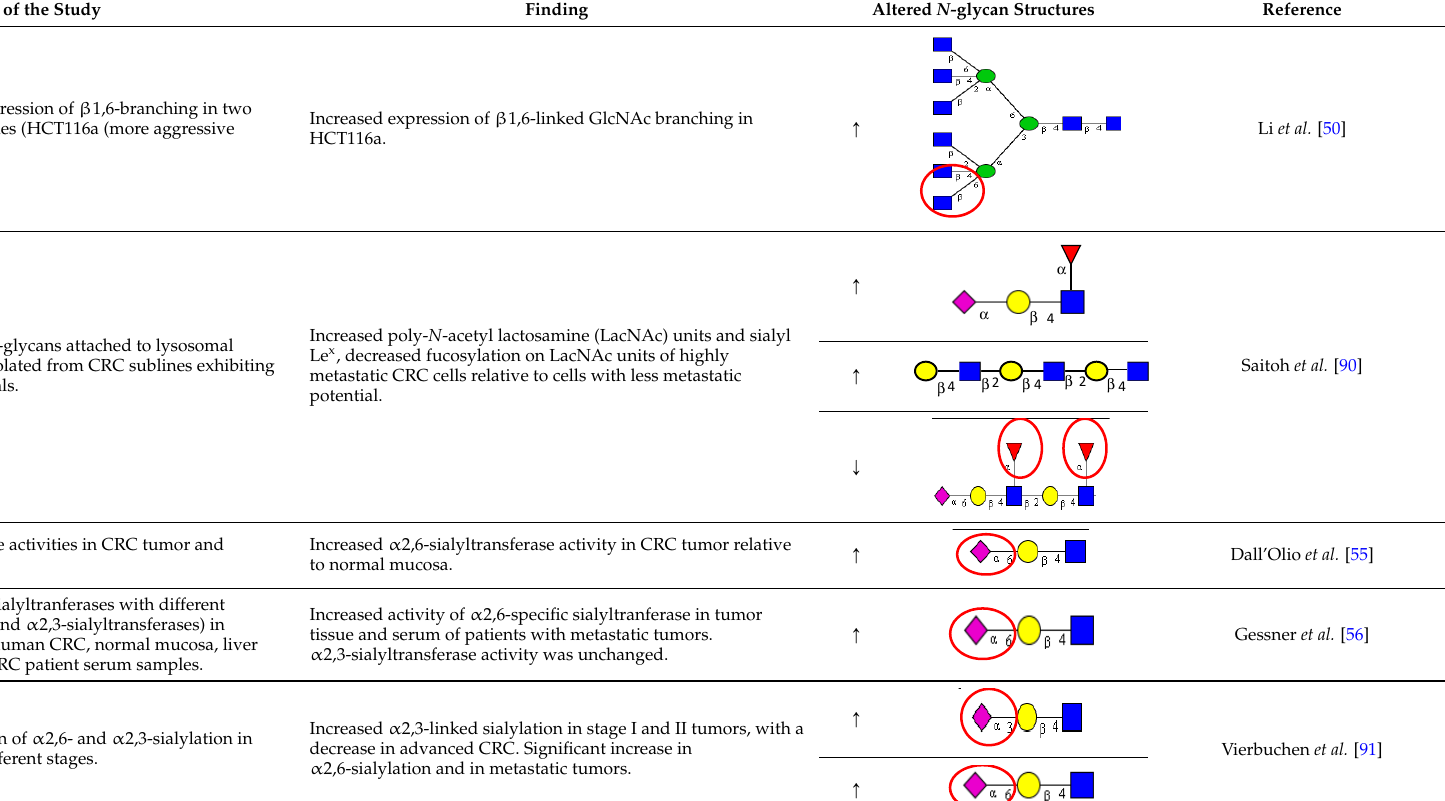
Table 1. N -glycan alterations reported in different studies.